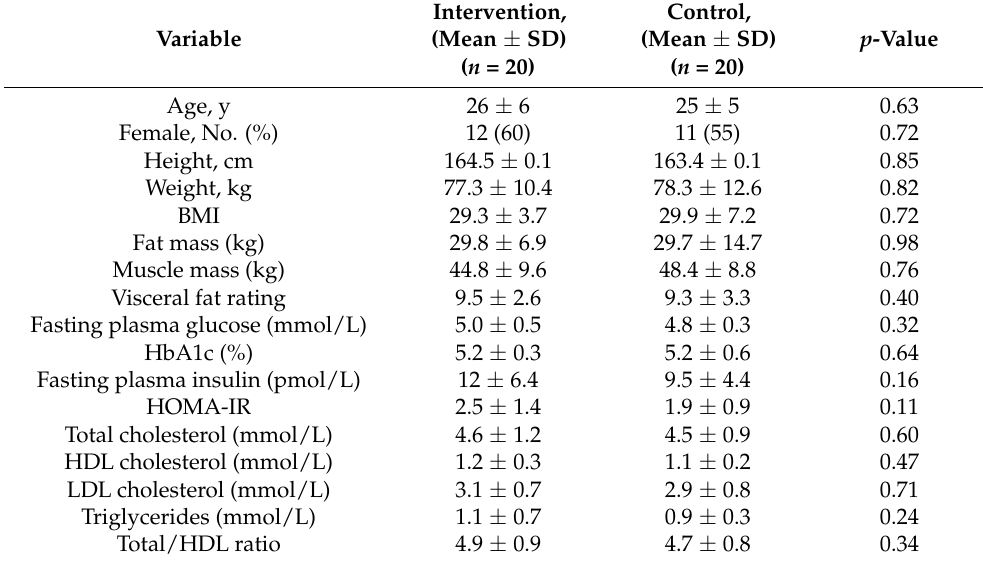
Table 1. Baseline characteristics of participants.